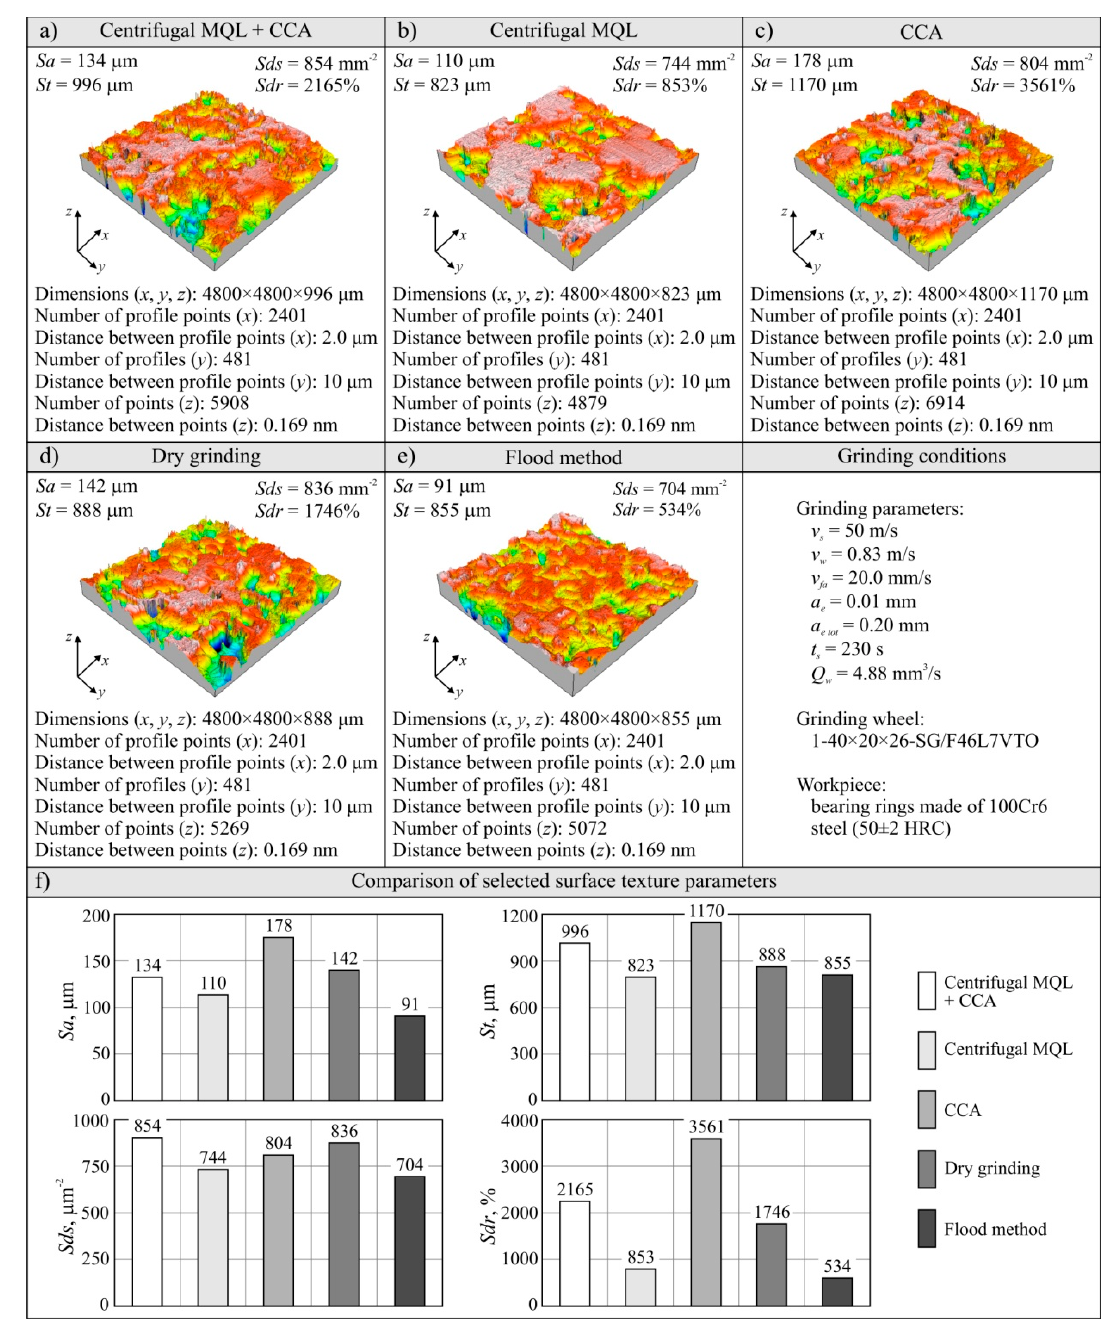
Figure 10. Microtopographs ( a – e ) and selected parameters of the geometrical structure of the GWAS ( f ) after grinding with different conditions of cooling and lubrication.